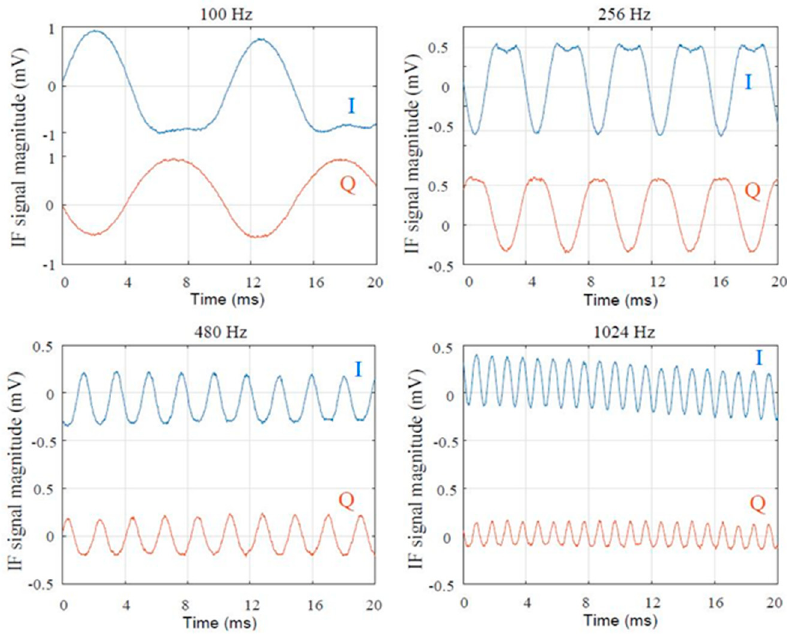
Figure 51. Measurement results of quadrature signals for different tuning forks.